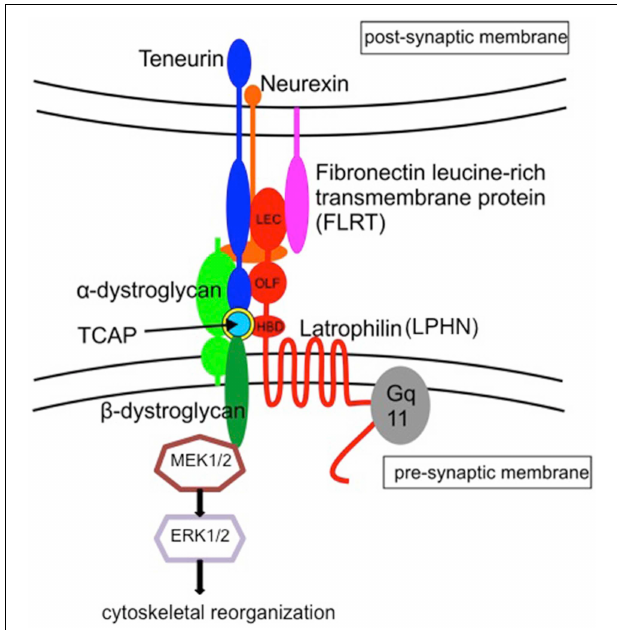
FIGURE 2 | Schematic interpretation of the teneurin/TCAP-latrophilin complex in the trans-synaptic region. Current evidence suggests that teneurins interact with both the lectin-like (LEC) and olfactomedin-like (OLF) binding domains. We further postulate that TCAP interacts with the hormone-binding domain (HBD) of latrophilin, and associates with β -dystroglycan to activate the MEK-ERK1/2 pathway leading to cytoskeletal reorganization and synaptic plasticity (Adapted from Chand et al., 2012b). Teneurin/TCAP and latrophilins, together with α –dystroglycan, neurexin and fibronectin leucine-rich transmembrane protein (FLRT) play a role with the stabilization of the trans-synaptic